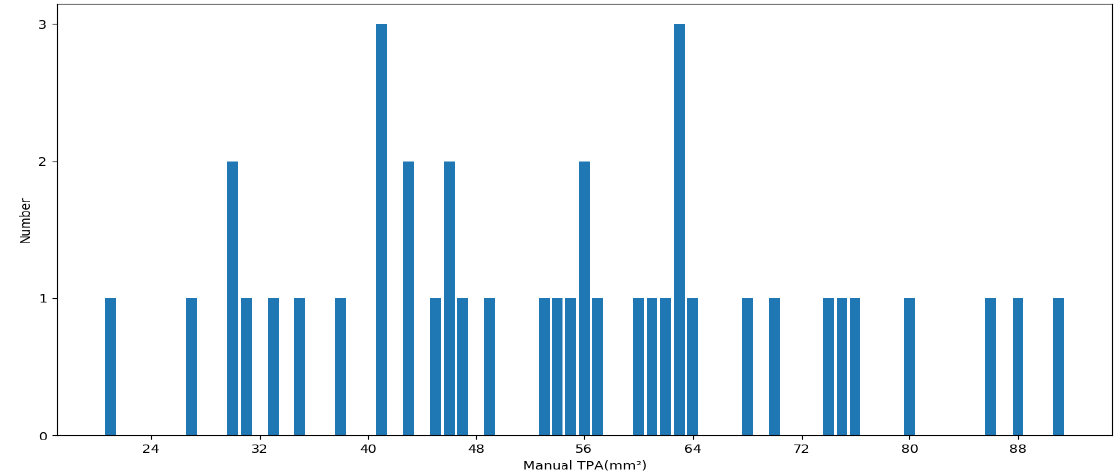
Figure 8. The total plaque areas’ distribution for 40 patients with severe stenotic plaques.